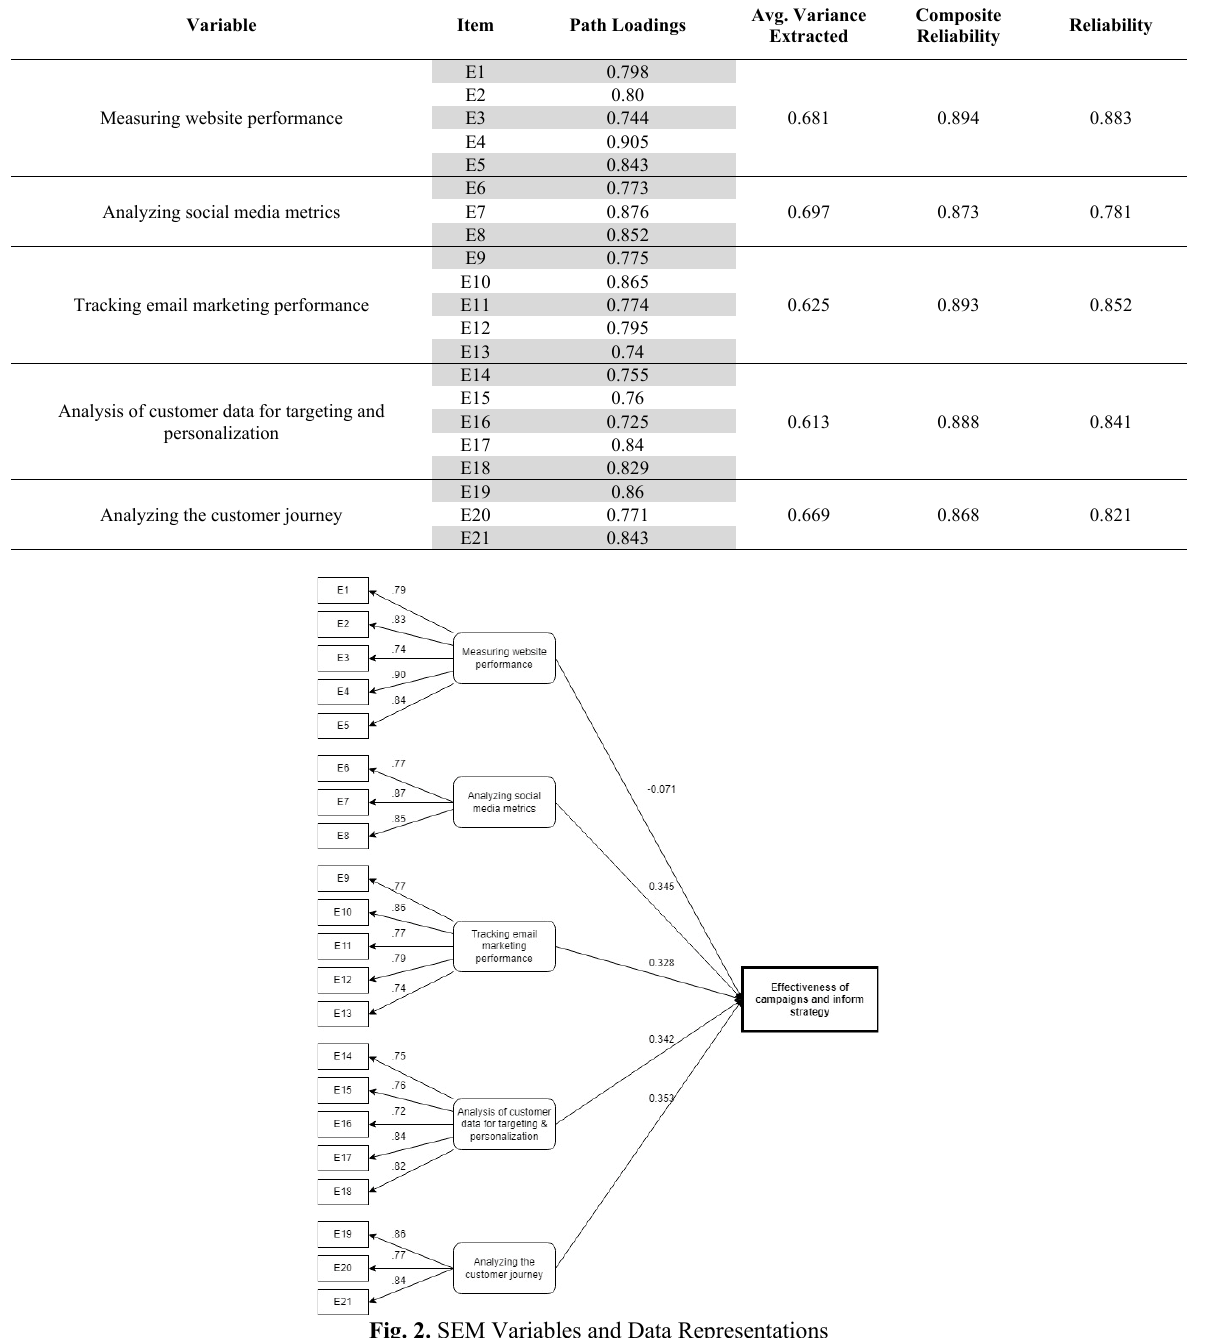
Measurement Model Synopsis